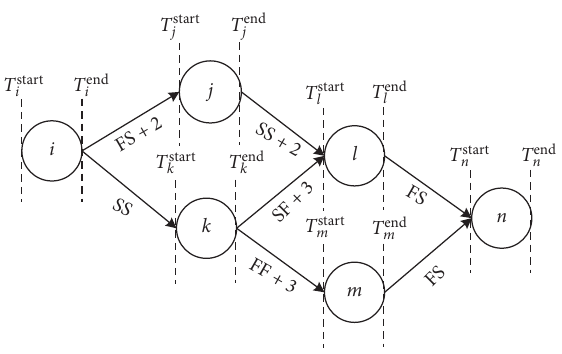
Figure 1: AON network